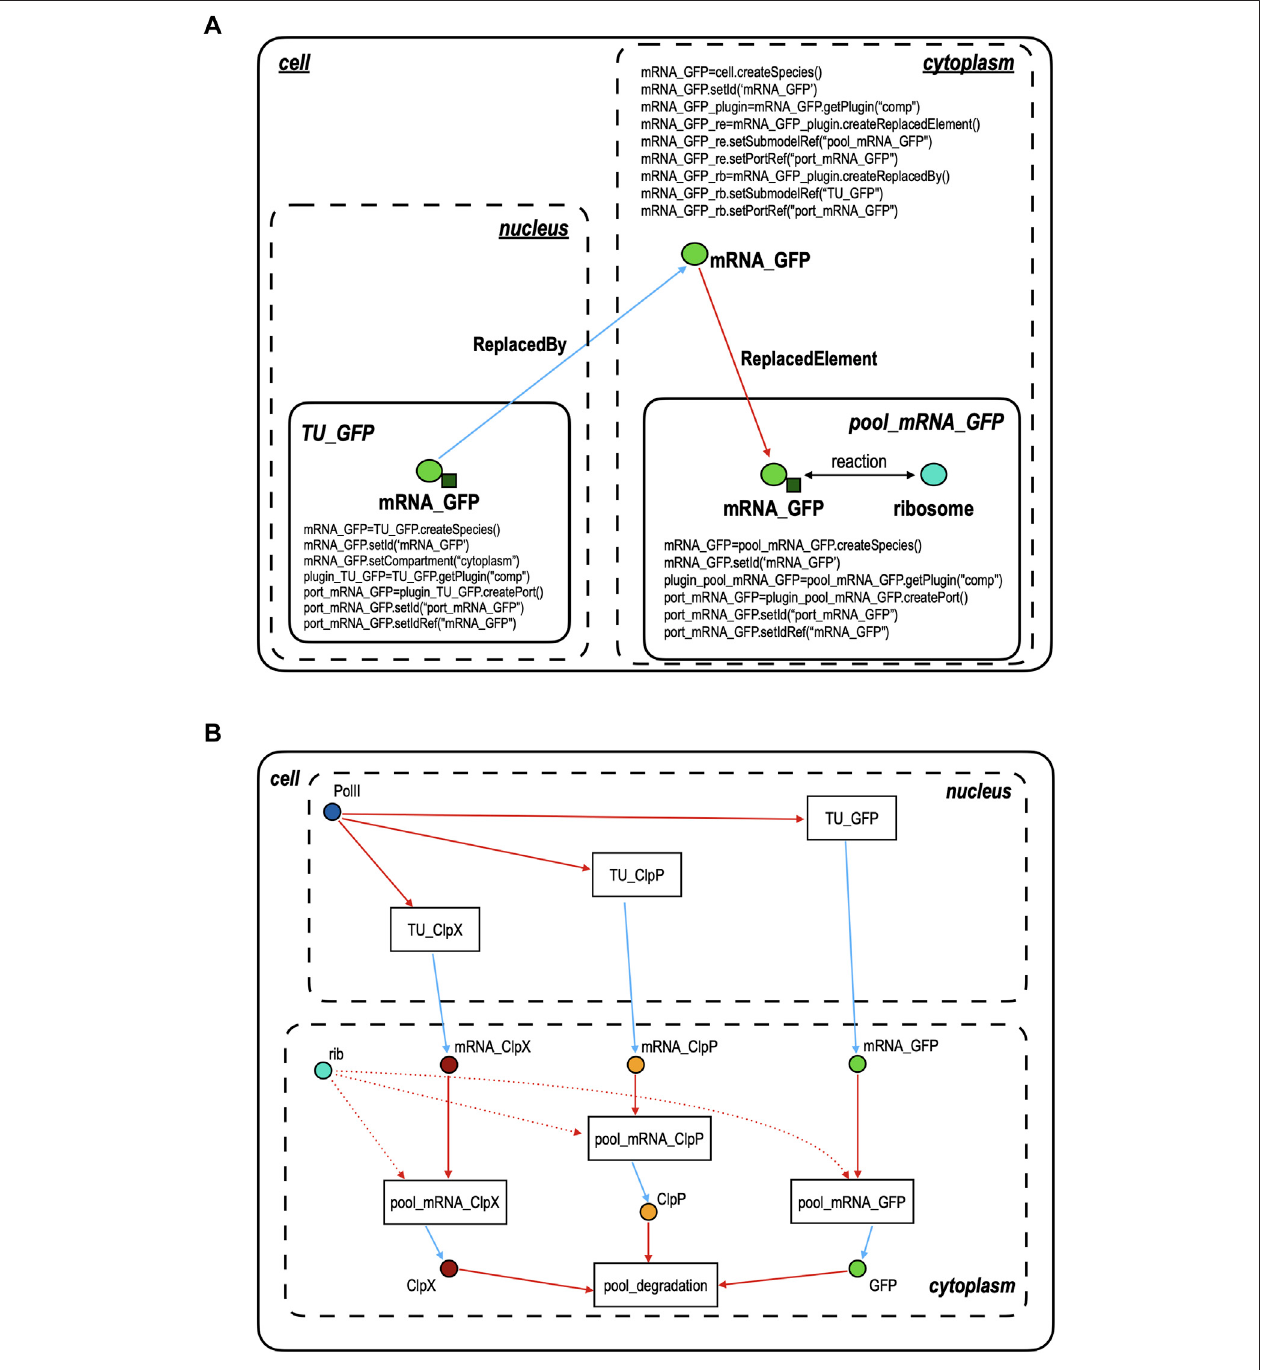
FIGURE 2 | Connecting modules in SBML3-comp. (A) Port objects (represented as small dark green squares) are instantiated in the TU_GFP and pool_mRNA_GFPmodulesandrefertothespeciesmRNA_GFP (alightgreencircle) — acopyofwhichispresentineach ofthetwomodules.Portspermittolinkthetwo modules indirectly, i.e., via a third copy of mRNA_GFP that lies in the cytoplasm (cell module) and is connected to the mRNA_GFP inside TU_GFP via a ReplacedBy object(cyanarrow)andtothemRNA_GFPinsidepool_mRNA_GFPviaaReplacedElementobject(redarrow). (B) ModularmodelofthegalactoserespondingNOT gate shown in Figure 1A . Species, like mRNA_GFP, instantiated in the cell model are responsible for the connection between at least two modules. As in Figure 2A , all cyanarrowsrepresentaReplacedByrelationandtheredarrows(straightordotted)aReplacedElementone.Galactose,thecircuitinput,isnotshownsinceitspresence or absence is determined by changing the value of the transcription initiation rate of pGAL1, which belongs to the module TU_ClpX. It should be noted that the circuit design still follows the idea to have two main kinds of module, like in our piece of software “ Parts and Pools ” . However, by using SBML3-comp, some Pools become redundant and are replaced by single species, whereas Parts are no longer modeled separately because, as explained in the main text, TUs represent now the smallest circuit components. This assumption permits to remove several species (compounds) and reactions that were necessary to describe the interactions between RNA polymerases II and the DNA Parts — and also between the ribosomes and the mRNA segments.